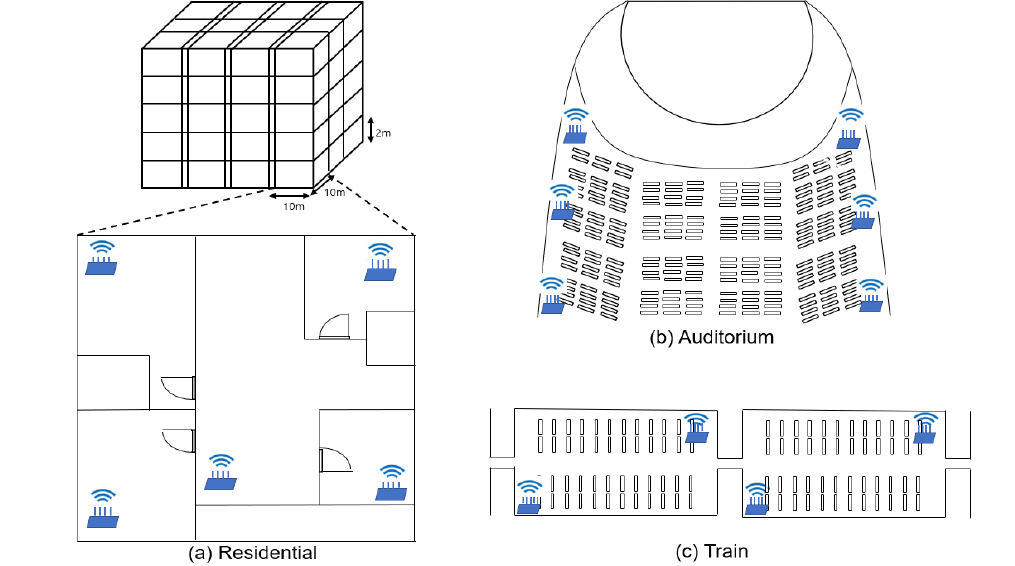
Figure 2. Three densely deployed APs scenarios of wireless devices. ( a ) represents a plausible residential scenario which is composed of densely deployed multiple APs in an apartment. ( b ) is a scenario for multiple APs in an auditorium. ( c ) is an example of densely installed APs scenario in a